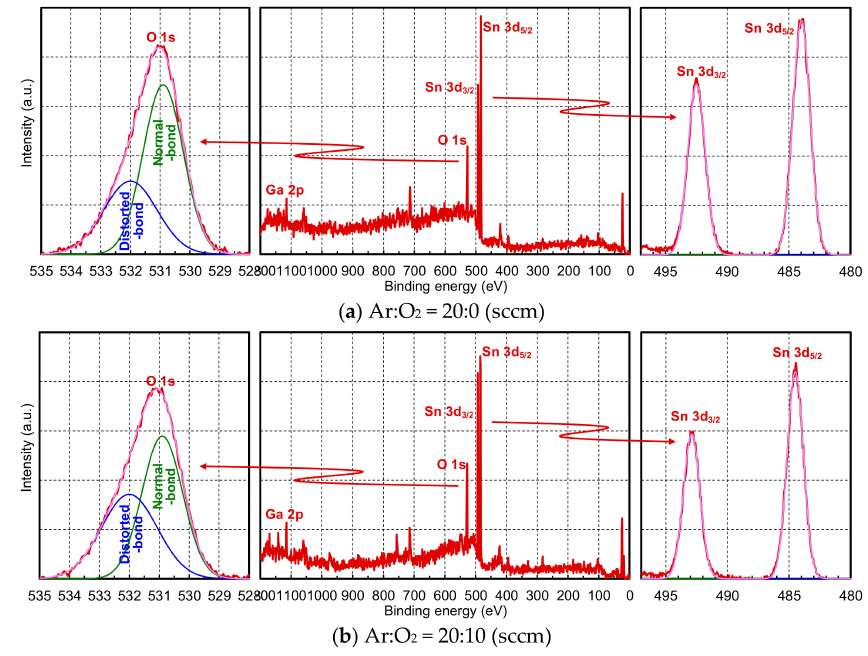
Figure 2. X-ray photoelectron spectroscopy (XPS) spectrums of the α -GTO thin films. ( a ) Ar:O 2 = 20:0 (sccm), ( b ) Ar:O 2 = 20:10